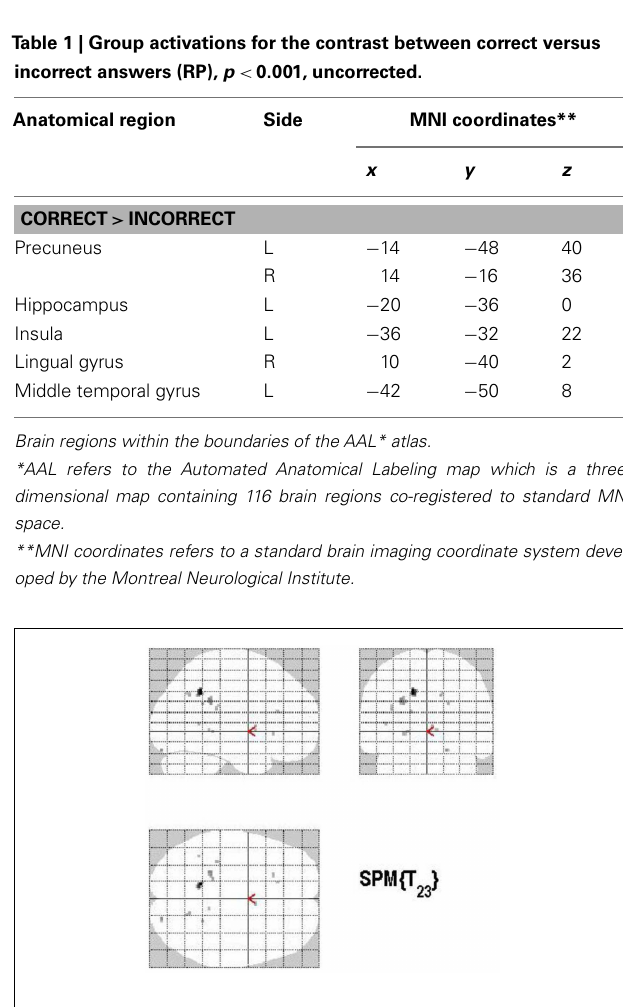
FIGURE 4 | Group activations for the contrast between correct versus incorrect answers (RETRIEVAL). Activations are superimposed on the anatomical group mean image (see Materials and Methods), depicting statistically significant relative increases in neural activity at p < 0.001, uncorrected. See Table 1 for the exact MNI